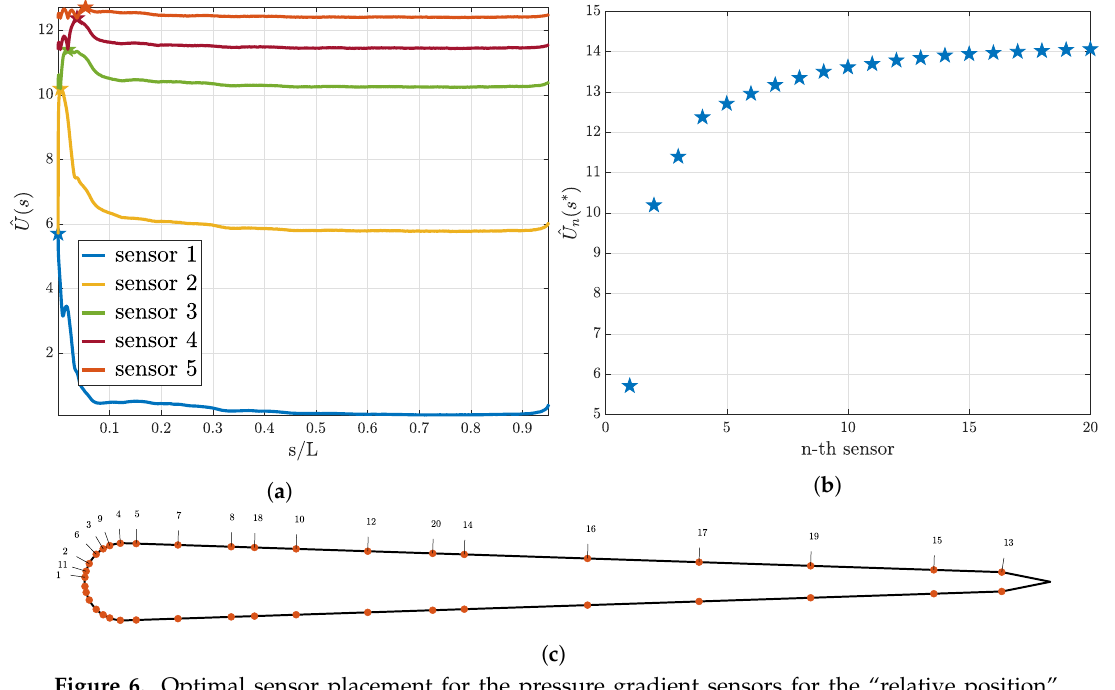
Figure 6. Optimal sensor placement for the pressure gradient sensors for the “relative position” experiment. In ( a ), the utility estimator for the first five sensors and in ( b ) the value of the utility estimator at the optimal sensor location for the first 20 sensors are presented. In ( c ), the distribution of the sensors on the swimmer surface is presented. Here, the numbers associated to each sensor indicate that this location is the i -th sensor location chosen according to Equation